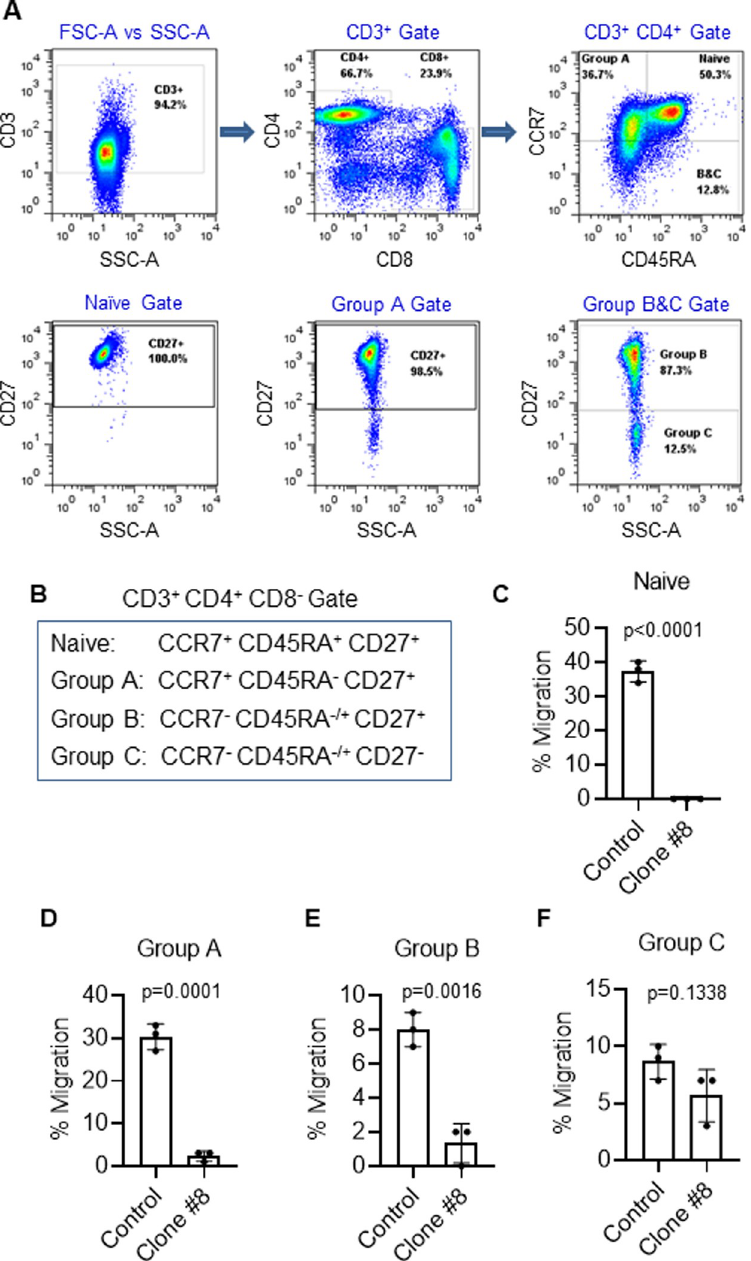
Fig 3. Inhibition of T-cell subset migration towards CCL21 by C8. (A) Flow cytometric gating strategy for isolation of human Th-cell subpopulations for testing the effects of C8 on migration towards CCL21. Migration of defined populations of T cell subsets was determined using flow cytometry of the lower versus upper chambers in transwell chemotaxis assays with background migration (cells that migrated toward media with no chemokine) subtracted from total cells. (B) Surface biomarker identification of Th-cell subsets tested in these experiments. (C-F) Fractional migration towards CCL21 inhibited by C8 in these T-cell subsets. Na ï ve Th-cells had the greatest migration towards CCL21 and were the most inhibited. Effect of C8 on migration towards CCL21 decreases as Th-cells become more mature. autoimmune disease is mediated by a distinct mechanism [7]. C8 did not bind to the endothe- lium of any of the 6 cases of synovium in rheumatoid arthritis (Fig 4, right lower panel).